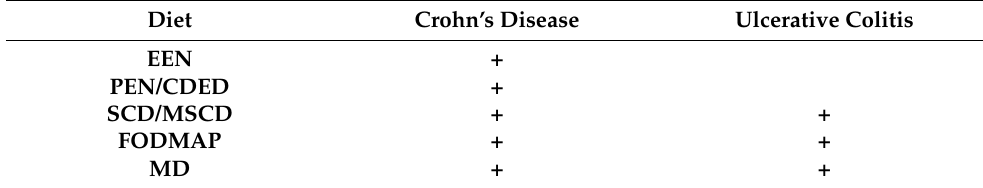
Table 1. Dietary interventions for Crohn’s Disease and Ulcerative